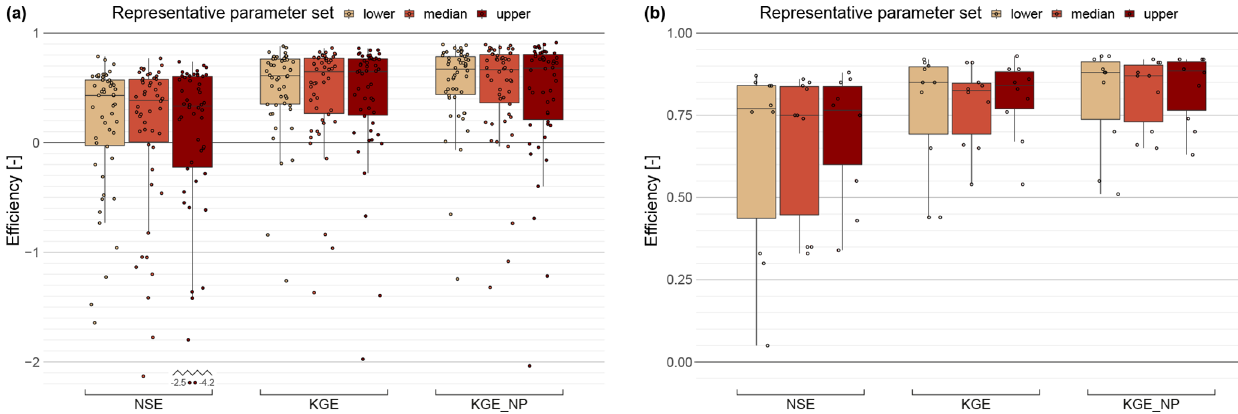
Figure 6. Model efficiencies at an hourly time step over the period 1974–2014 for HBV ( a : 50 gauged sub-catchments) and RS MINERVE ( b : 10 gauged output nodes) showing the three representative parameter sets. The efficiency criteria used are Nash–Sutcliffe (NSE), Kling– Gupta (KGE) and non-parametric Kling–Gupta (KGE_NP). All criteria have an upper bound of 1 (which means ideal performance) and are unbounded towards the